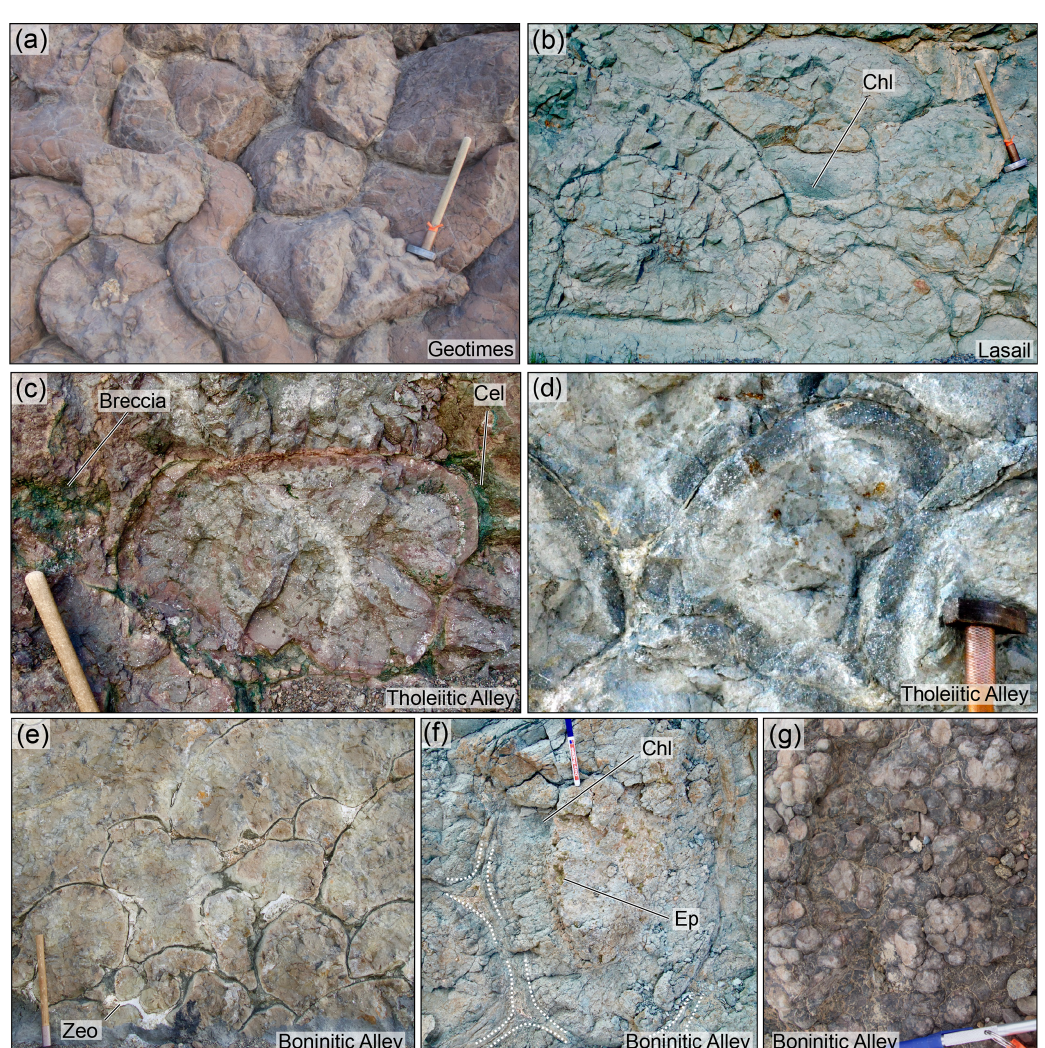
Figure 3. Field photographs of typical outcrops of the mapped volcanic units, with UTM 40N location coordinates (orientations: east, north; unit: metres). Hammer for scale is 50cm long. (a) Geotimes greenschist-facies spilitic pillow flows: Wadi Jizi type locality (438288mE, 2685876mN). (b) Lasail greenschist-facies spilitic pillow and pahoehoe flows showing abundant chlorite (Chl): Wadi Lasail (440680mE, 2683521mN). (c) Tholeiitic Alley zeolite/pumpellyite-facies spilitic pillow flows and hyaloclastite breccia (light streak in centre pillow is a road-cutting artefact). Note sea-green celadonite (Cel) alteration in inter-pillow and breccia, yellowish-beige pumpellyite alteration around pillow rim, abundant zeolite-filled vesicles, and dark grey spots (spherules) throughout pillow (sample TB4-17J): Suhaylah section, blasted roadcut around electricity pylon (434460mE, 2683370mN). (d) Primitive Tholeiitic Alley pillows with highly vesicular pillow rims and dark spots throughout the pillow cross section: roadcut near Maqail South mine (453534mE, 2661208mN). (e) Boninitic Alley pillow lavas with weak pumpellyite–clay altered groundmass and zeolite altered (Zeo) inter-pillows (sample TB2-45B; 448940mE, 2712935mN). (f) Boninitic Alley greenschist-facies pillow lavas with three pillow triple-junctions marked by dotted lines. Note pale chlorite–albite alter- ation with chlorite–epidote replacing olivine in pillow rims and large epidote-filled vesicles (Ep) through pillow core: Wadi Zab’in (approx. 436040mE, 2714170mN). (g) Boninitic Alley pillow lava showing globular/spherulitic texture typical of Alley (particularly Boninitic Alley) lavas: Wadi Bidi (455370mE,